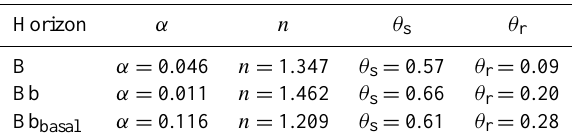
Table 2. Parameters of the van Genuchten model, as in De Vita et al. (2012).